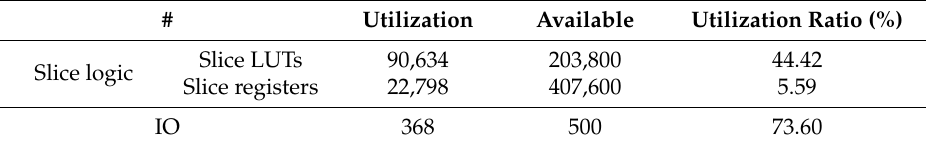
Table 9. Utilization ratio of resources for the proposed FPGA-based